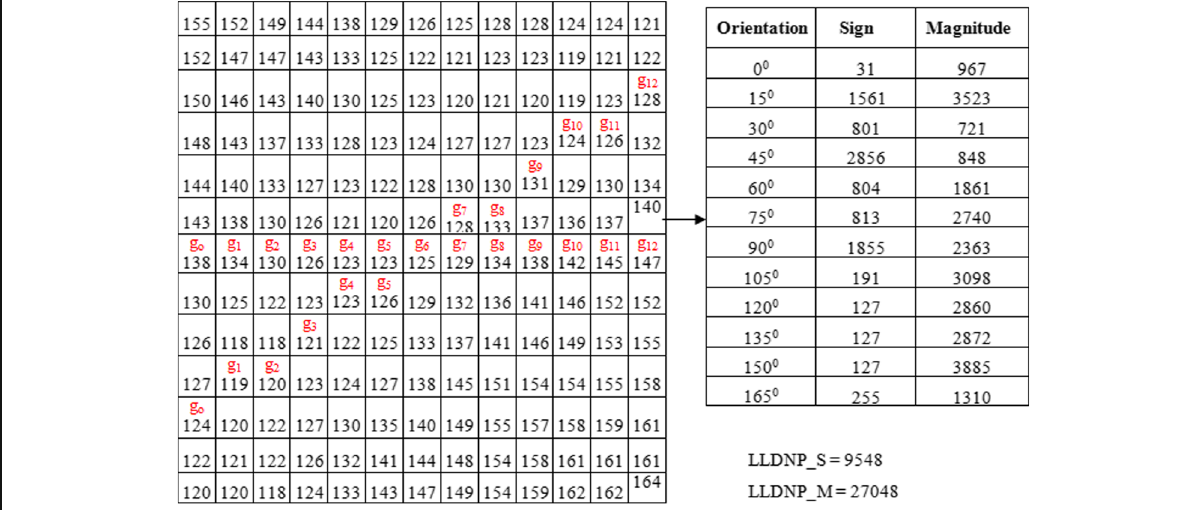
Fig. 1 Example of generating LLDNP_S and LLDNP_M code ( g values are shown for 0° and 30°). For 13 × 13 window size, the LLDNP sign and magnitude patterns are calculated for 12 directions. Finally, from 12 values, the process of computing LLDNP_S and LLDNP_M pattern is shown in the